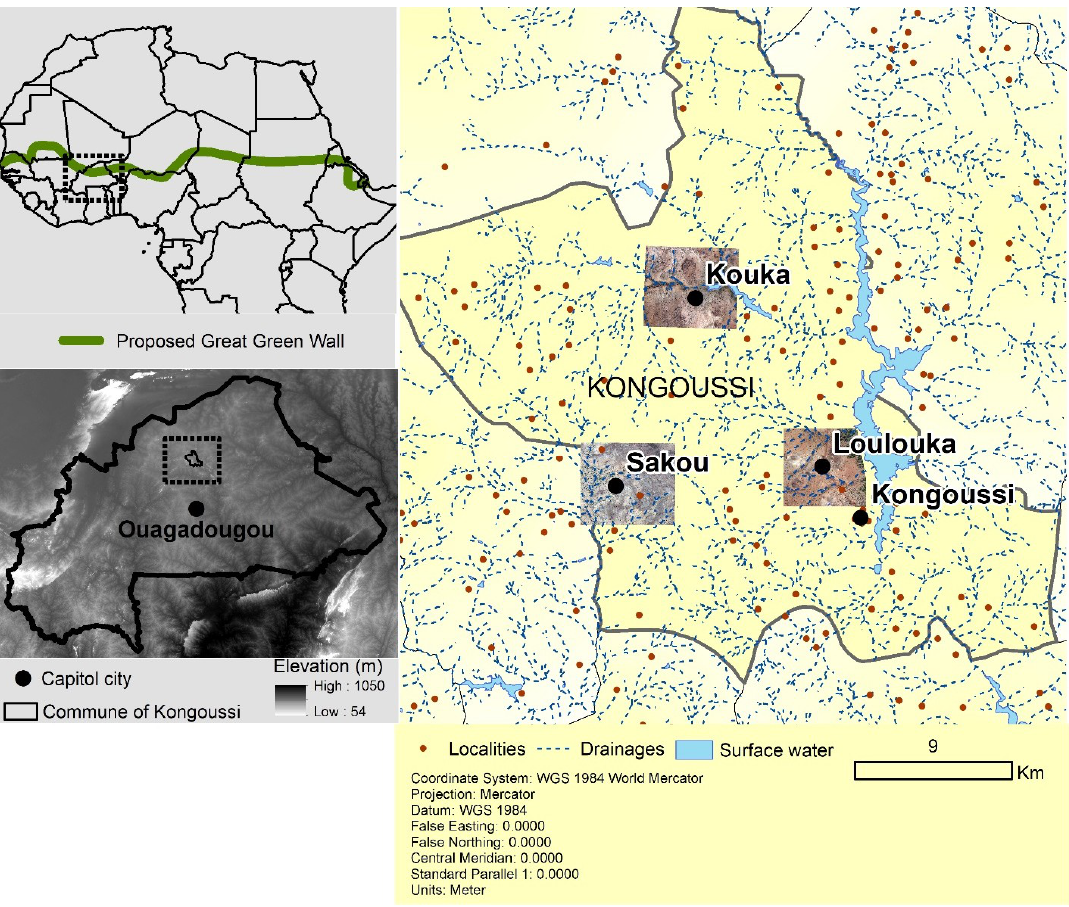
Figure 1. Map indicating proposed GGW ( upper left ); Map of Burkina Faso ( lower left ); Map of the Commune of Kongoussi and study terroirs ( right ) – dotted boxes designate inset maps.